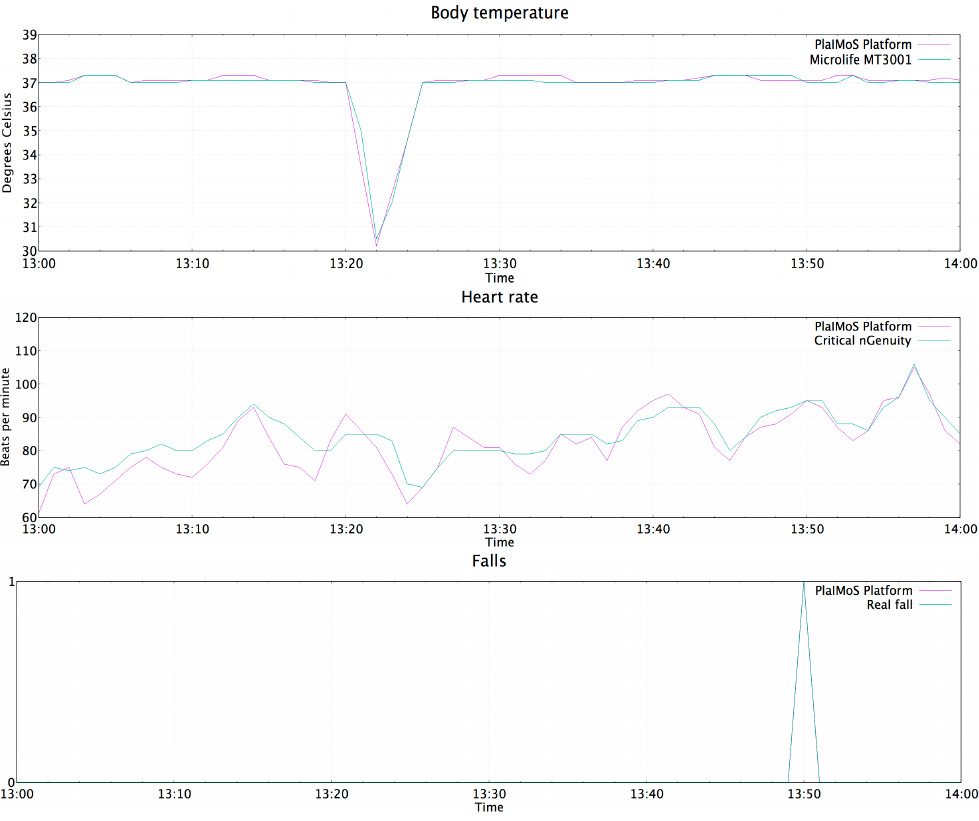
Figure 18. Values obtained by the PlaIMoS remote node.